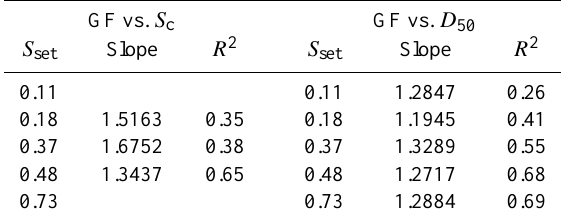
Table 2. A table of ODR slopes and R 2 for straight line fits to N CCN derived from D thres ,κ, GF vs. D thres ,S D thres , D50